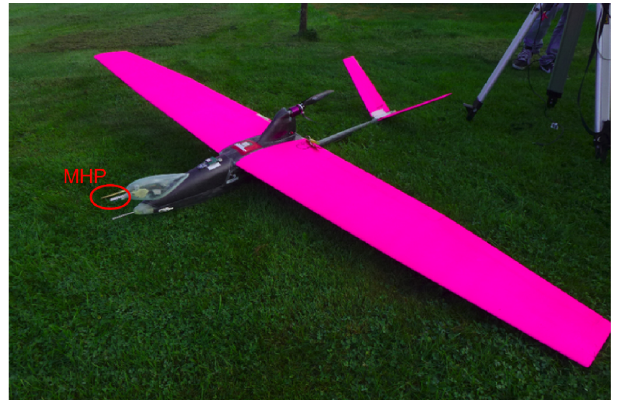
Fig. 1. Research RPA MASC. The position of the MHP approxi- mately 15cm in front of the fuselage nose tip is depicted with the red